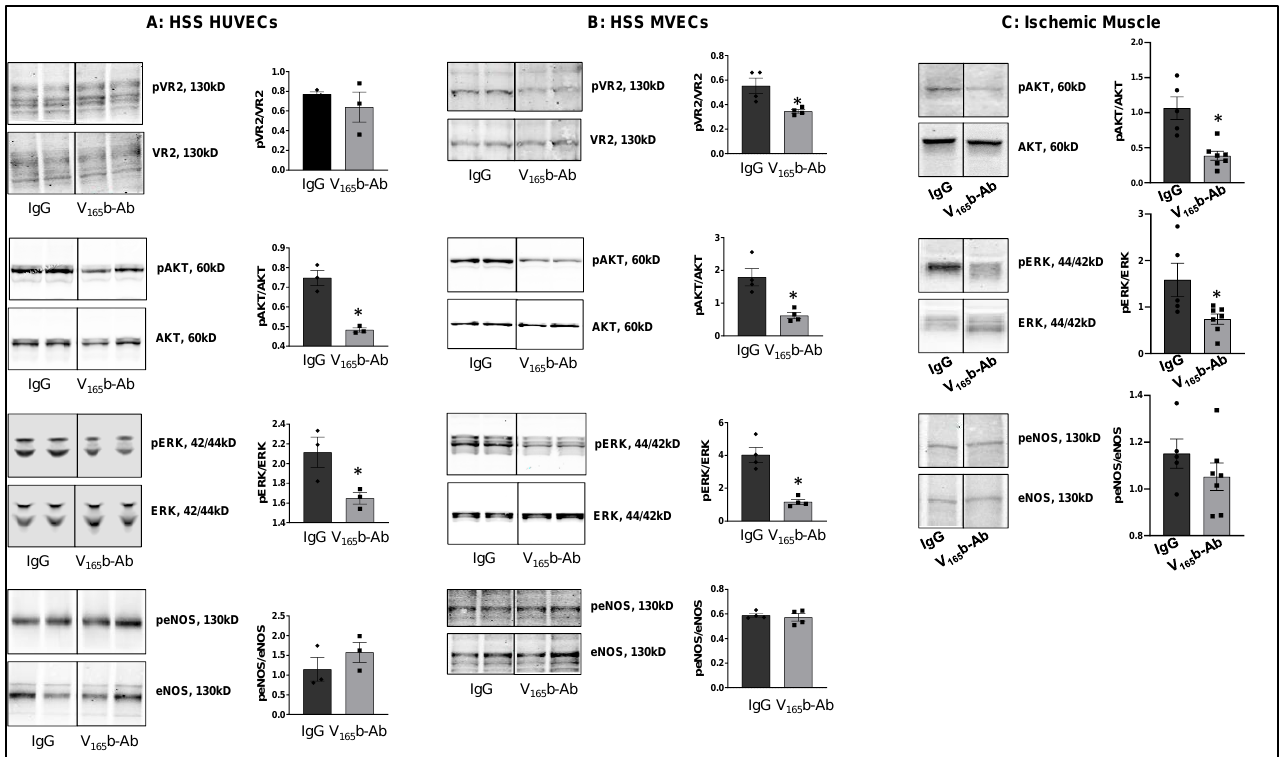
Figure 2. VEGF 165 b inhibition decreases VEGFR2 signaling in vitro and in vivo: Immunoblot analysis of pVR2(Y1175)/VR2, pAKT/AKT, pERK/ERK, peNOS/eNOS in ( A ) HSS-HUVECs treated with IgG or VEGF 165 b-Ab for 24 h. n = 3. Unpaired t -test. ( B ) HSS-MVECs were treated with IgG or VEGF 165 b-Ab for 24 h. n = 4, Unpaired t -test. ( C ) Immunoblot analysis of pAKT/AKT, pERK/ERK, peNOS/eNOS in Balb/c mice ischemic muscle treated with IgG or VEGF 165 b-Ab at day 3 post-HLI. n ≥ 5. Unpaired t -test. * p < 0.05 considered significant. Data Mean ± SEM. To confirm the role of VEGF 165 b inhibition in regulating VEGFR2 signaling in vivo, we performed immunoblot analysis of day 3 ischemic muscle samples treated with IgG or VEGF 165 b-Ab (200 µ g, i.m, three non-overlapping sites in Balb/c mice gastrocnemius and tibialis anterior muscles). Immunoblot analysis showed that VEGF 165 b-Ab significantly decreased pAKT (~5.1-fold) and pERK (~2.9-fold) activation with no changes in peNOS activation vs. IgG (Figure